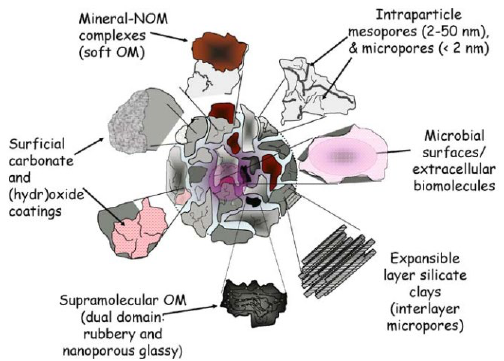
Figure 1. Structural properties, surface coatings, and porosity of geosorbents affecting transport-limited sorption kinetics (Jon Chorover and Mark L. Brusseau) [10].